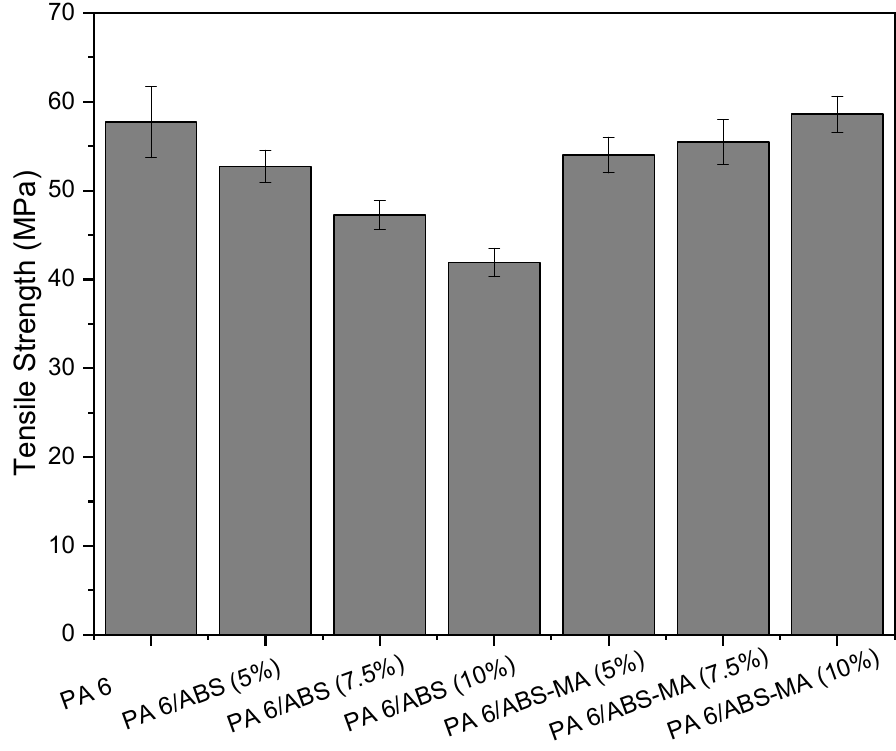
Figure 9. Tensile modulus of elasticity of PA6 and its binary blends.